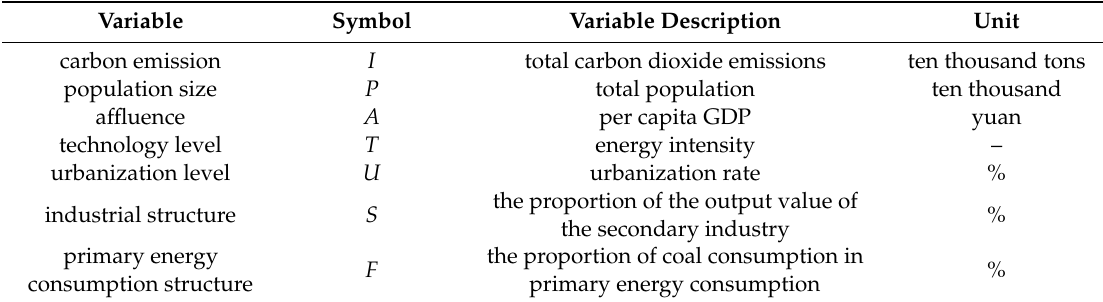
Table 3. The explanations of